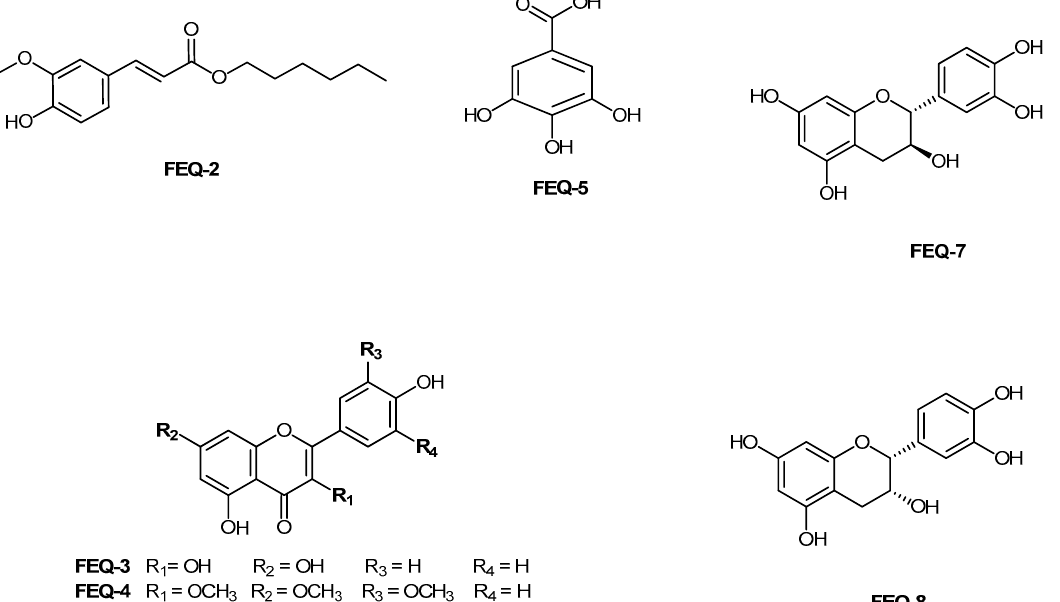
Figure 3. Structure of phenolic constituents from Entada spiralis methanol extract. Table 5. Identification of the aglycone flavonoids isolated from the methanol extract of E. spiralis stem bark.